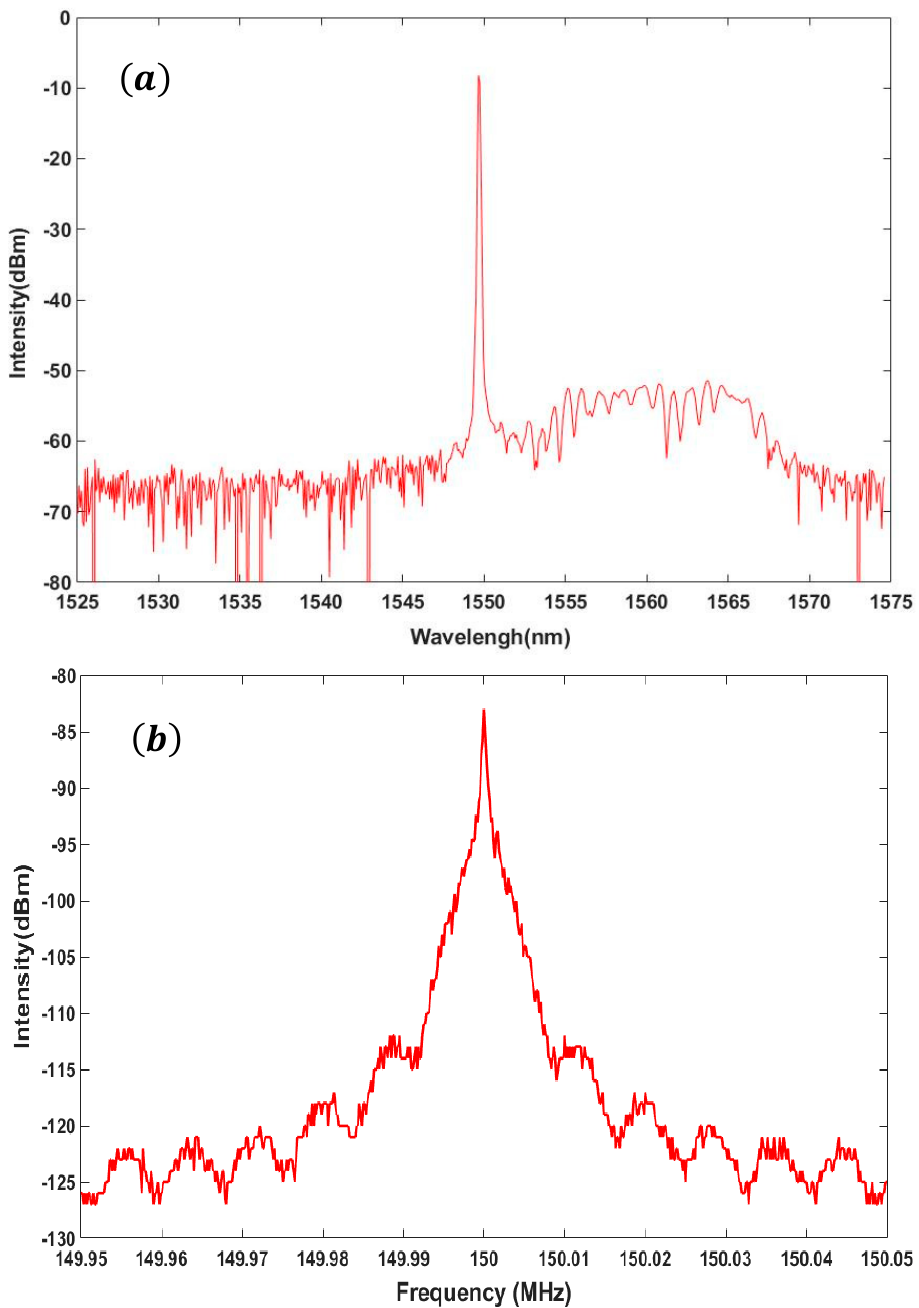
Figure 6. Output spectrum and power spectrum of 25 km delayed self-heterodyne of 20 W laser signal. ( a ) Shows the output spectrum of the power amplifier at the maximum output power. ( b ) Shows the actual recorded power spectrum at the maximum output power of laser measured with 25 km delayed fiber.